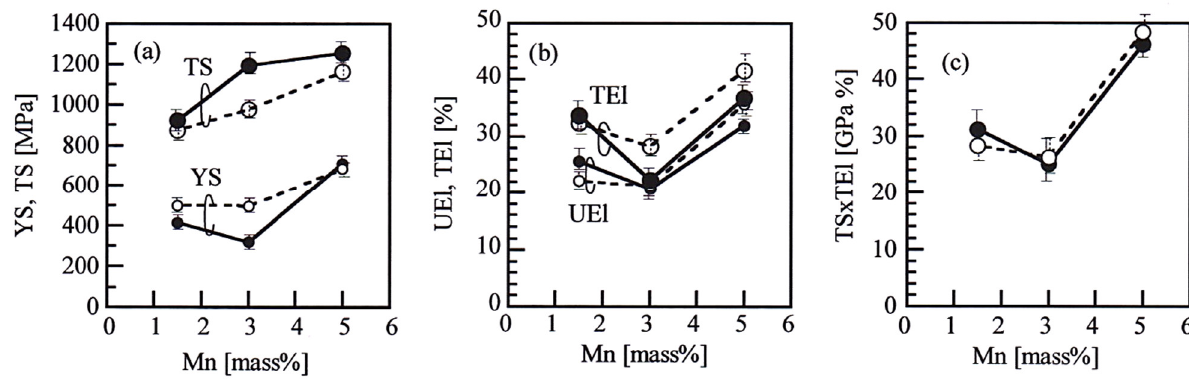
Figure 7. Variations in ( a ) yield stress or 0.2% offset proof stress (YS) and tensile strength (TS), ( b ) uniform and total elongations (UEl and TEl), and ( c ) the product of TS and TEl (TS × TEl) as a function of Mn content in the steels subjected to the AC ( ● ) and IT ( ○ ) processes after intercritical annealing.